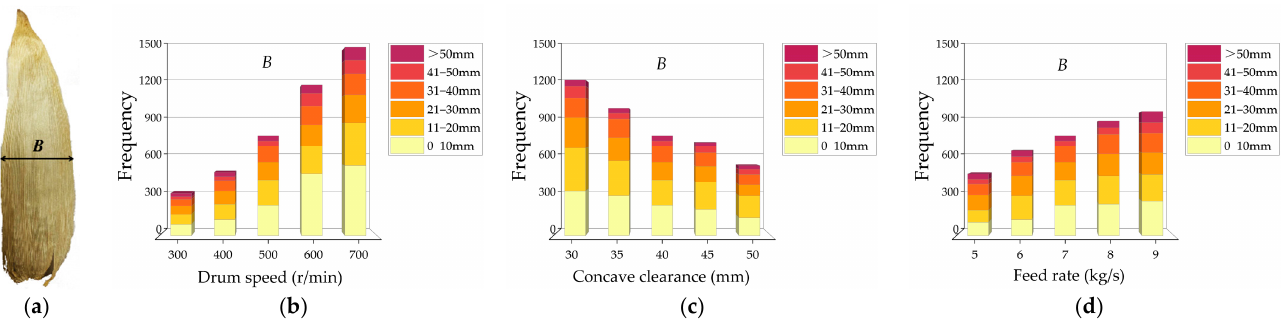
Figure 8. Characteristic size and particle size distribution of corn husks: ( a ) Characteristic size of corn husk; ( b ) B of corn husks for different drum speeds; ( c ) B of corn husks for different concave clearances; ( d ) B of corn husks for different feed